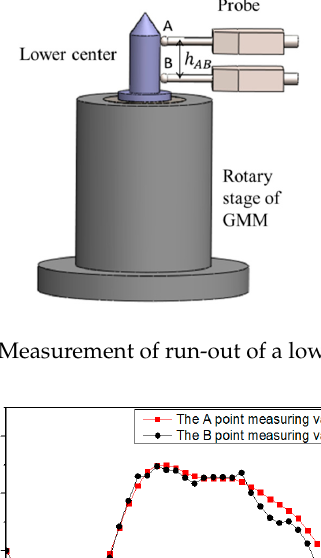
Figure 8. Measured run-out errors of the lower center.